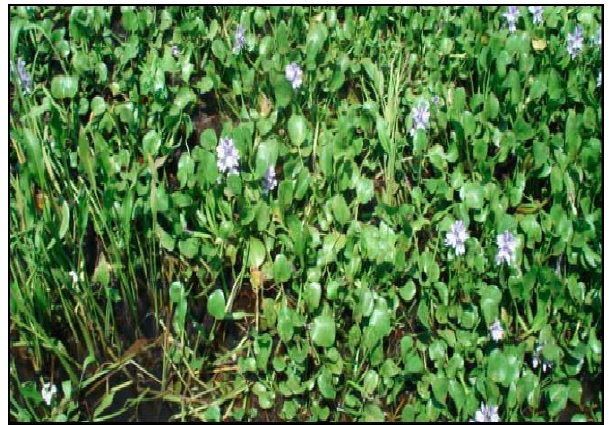
Figure 1: The floating aquatic vegetation, Eichhornia crassipes (waterhyacinth), with its purple flowers and other emergent plants.